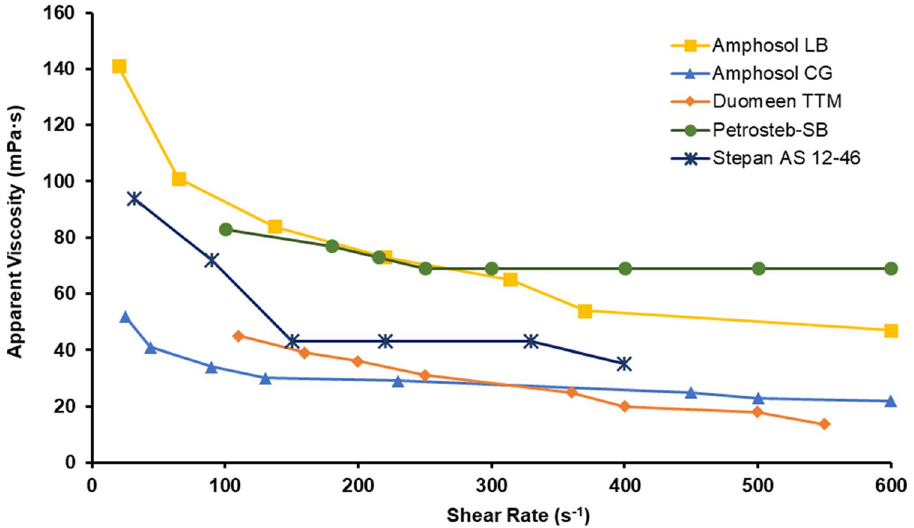
Figure 12. Foam apparent viscosity for 0.5 wt% Petrostep SB, Amphosol LB, Amphosol CG-50, Duomeen TTM, and Stepan AS 12-46 surfactant solutions in Brine 1 at 70% foam quality, 12 MPa, and 90